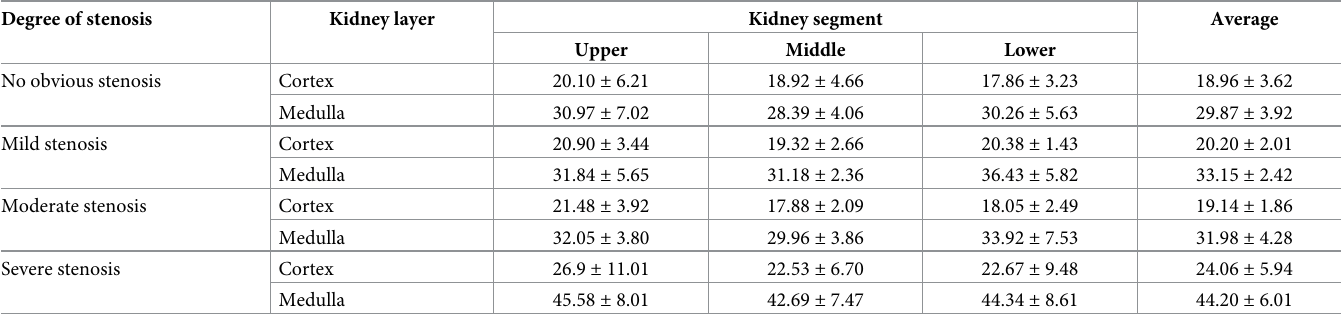
Table 5. R2 � value analysis for subgroups with different degrees of renal artery